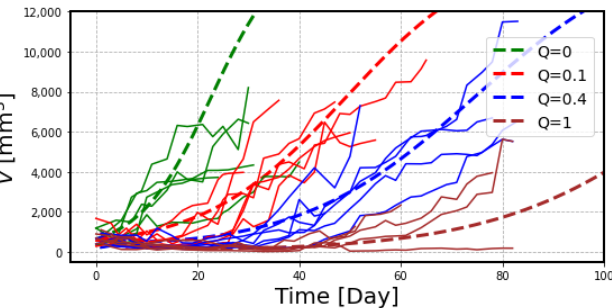
Figure 6. Estimated dose-response curves to reproduce the experimental data of 211 At treatment in xenograft model mice. Dashed curve lines demonstrate the tumor growth curves by administration of 0.1 MBq ( Q = 0.1), 0.4 MBq ( Q = 0.4), and 1 MBq ( Q = 1) in comparison with control mice ( Q = 0).